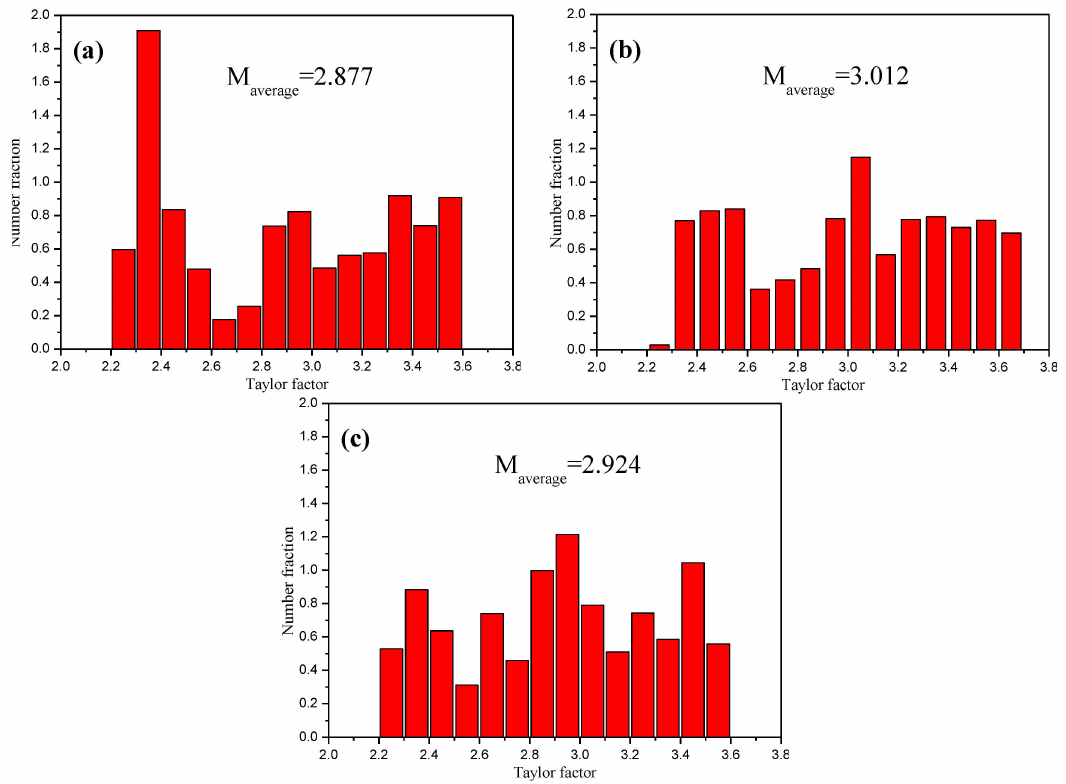
Figure 8. Taylor factors after solid solution ( a ) ε = 0% ( b ) ε = 30% ( c ) ε = 70%.